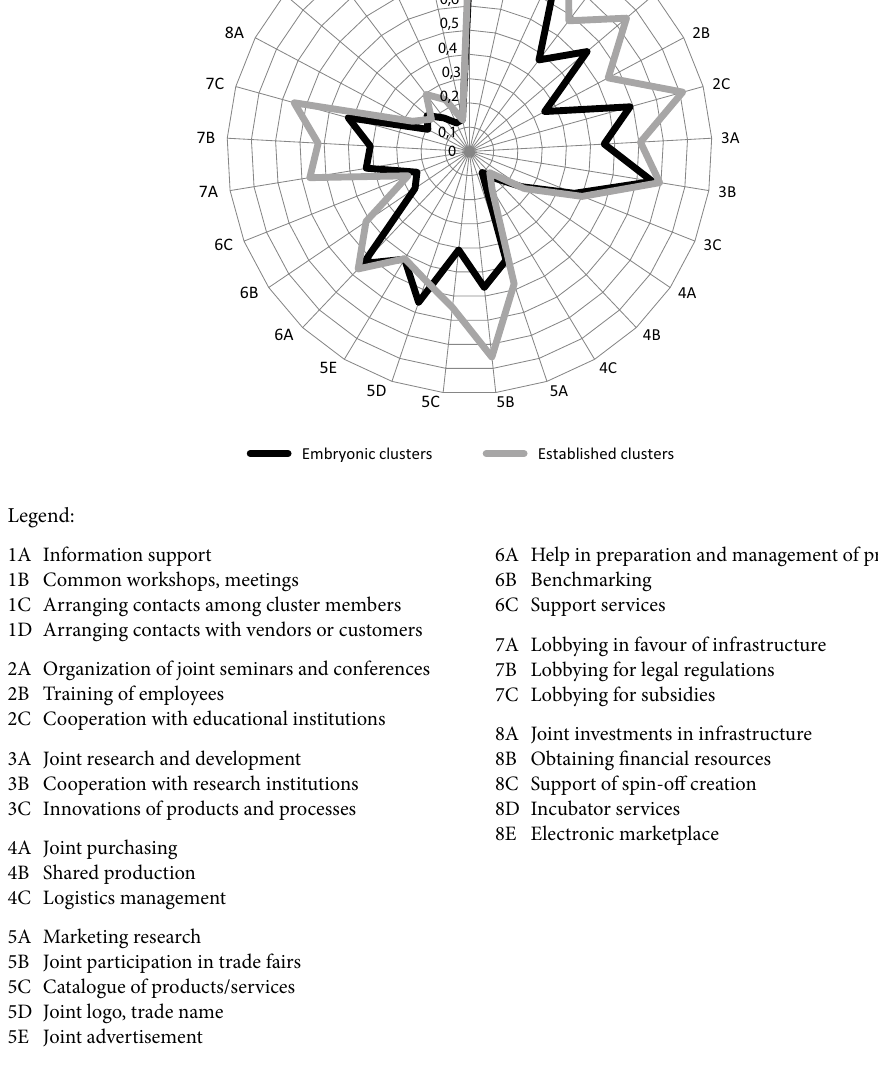
Fig. 1. A comparison of activities implemented by embryonic and established clusters